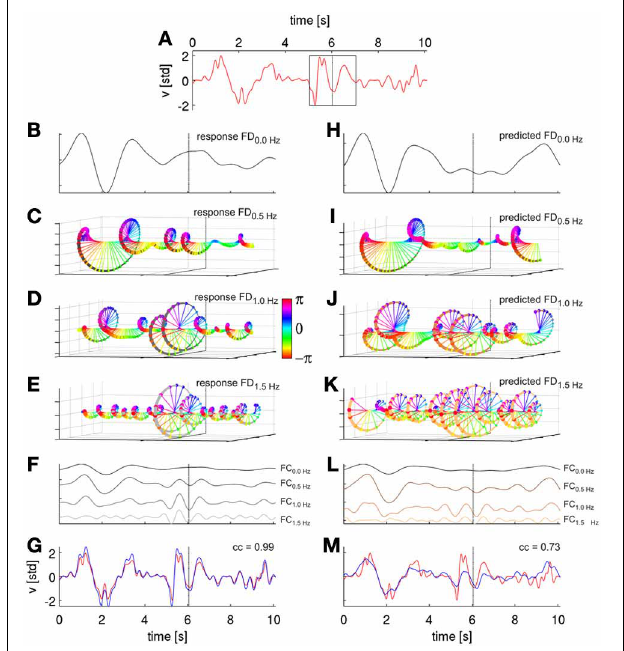
FIGURE 4 | Signal reconstruction from Fourier descriptors (FDs). FDs were derived by short time Fourier analysis (STFT) and are illustrated based on movement velocity data from a cross-validation fold of subject S1. (A) Ten seconds of decoded velocity (with direction indicated by its sign), a 2-s Hanning window around time t of the STFT (black rectangle). The dotted vertical lines in all following plots indicate values obtained (or predicted) from this time step. (B) FD time series of the first frequency bin f = 0 . 0Hz (FD 0 . 0Hz ), i.e., the real-valued DC component. (C) FD time series of the second frequency bin, f = 0 . 5Hz, i.e., the complex-valued FD 0 . 5Hz . FD( T , f ) at different time points T are color-coded based on the phases of the complex values. (D) Third frequency bin, f = 1 . 0Hz, FD 1 . 0Hz (E) Fourth frequency bin FD 1 . 5Hz . (F) Reconstruction of velocity frequency components at frequencies f (FC f ) of the first four FD f obtained from their inverse STFT (iSTFT). The FCs are plotted with different offsets for better visualization. (G) Reconstruction (blue) of original (red) velocity as shown in (A) as a sum of the first ten FC f , with a correlation coefficient of 0.99. Thus, the sum of the FCs converges back to the original signal; the algorithm, hence, worked as intended. (H–K) First four Fourier descriptors of the horizntal velocity as predicted from ECoG FD f features with time offset τ = 0s (using DAlg3, see Figure 3 ). (L) Reconstruction (by iSTFT) of predicted velocity FC f from the first four FD f . (M) Reconstruction of predicted velocity (blue) as a sum of first ten predicted FC f and the original velocity (red) from (A) . The correlation coefficient between executed and ECoG-decoded velocity was 0.73 for this particular